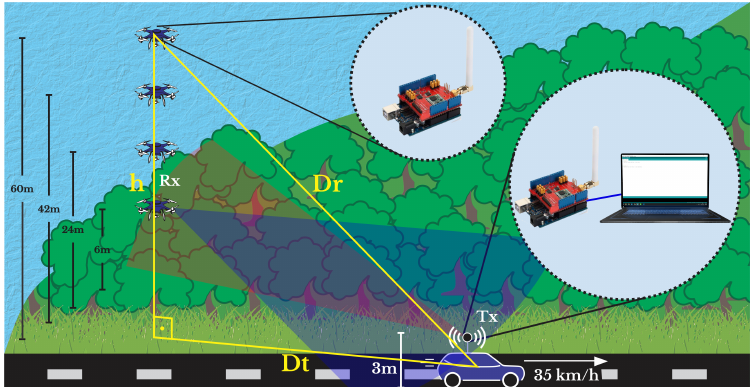
Figure 2. Measurement